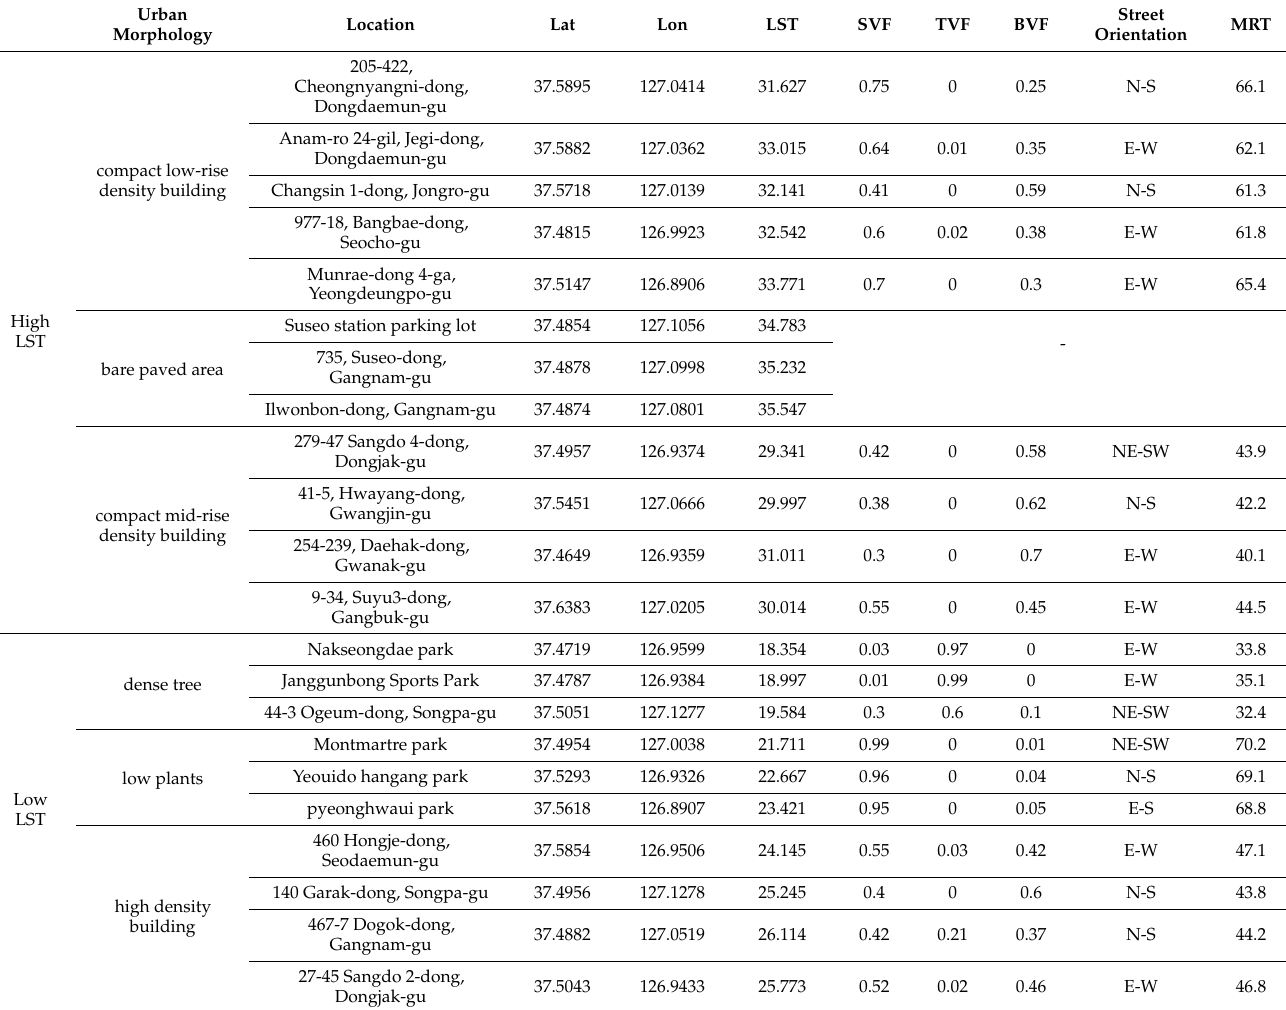
Table A2. Urban morphology, MRT, LST data for each point